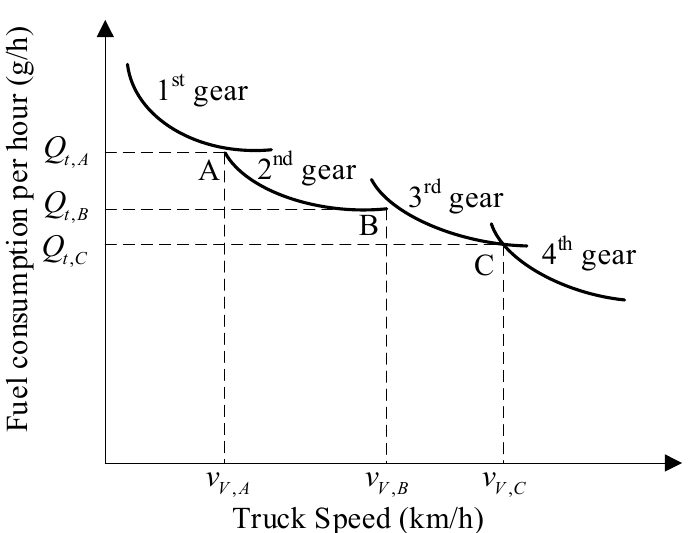
Figure 4. The relationship between fuel consumption per hour and truck speed at different gears. Integrating the shift points under different throttle openings, the traditional two-parameter economical shift curve of the truck without considering vehicle load and road slope ( M = M max , α = α 0 ) is obtained, as shown in Figure 5.